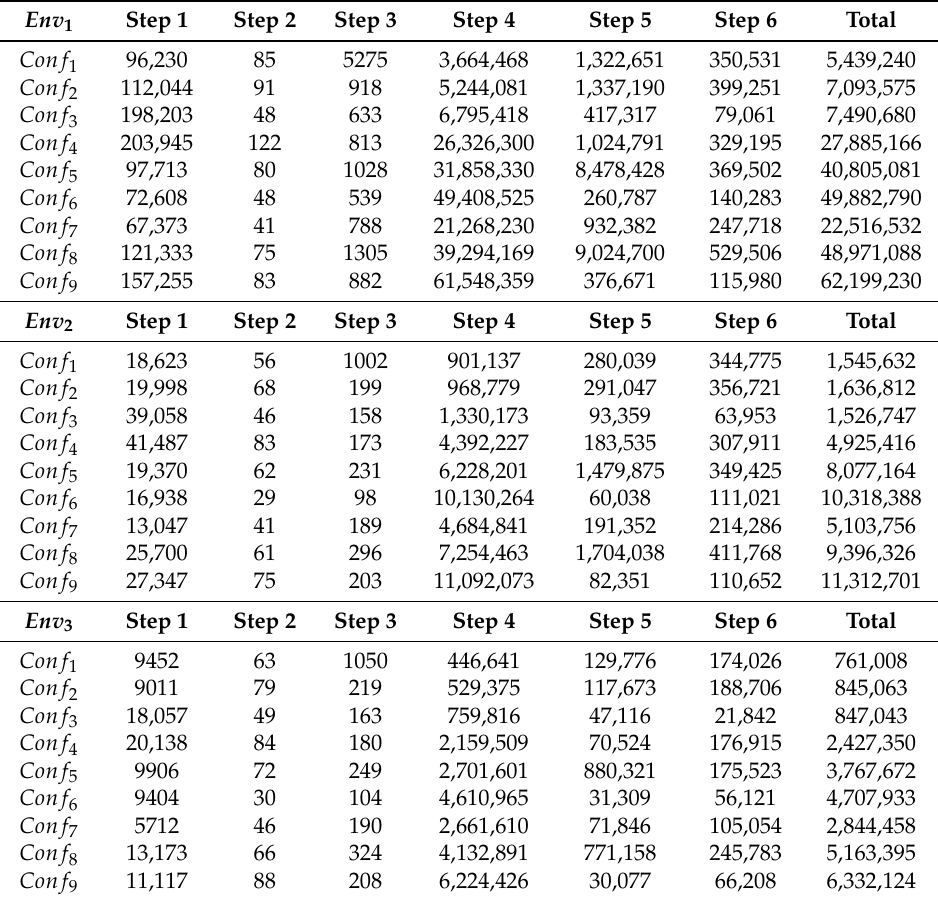
Table 6. Execution times for the corpus of 10,000 data sets (first Map-Reduce